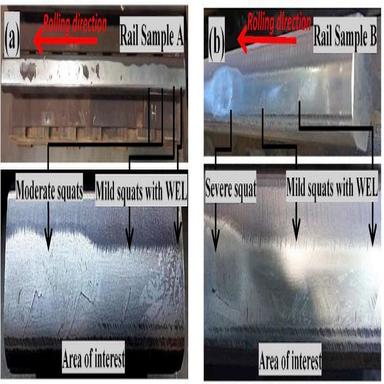
Two ex-service rails for investigation; (a) Rail sample A, (b) Rail sample B.